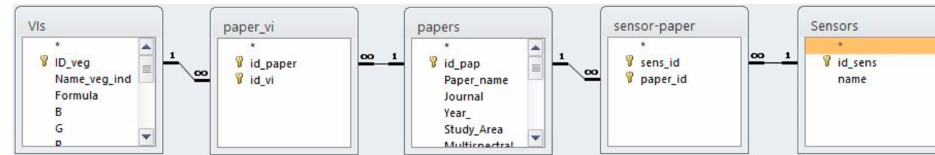
Figure 2. Relational Database structure.